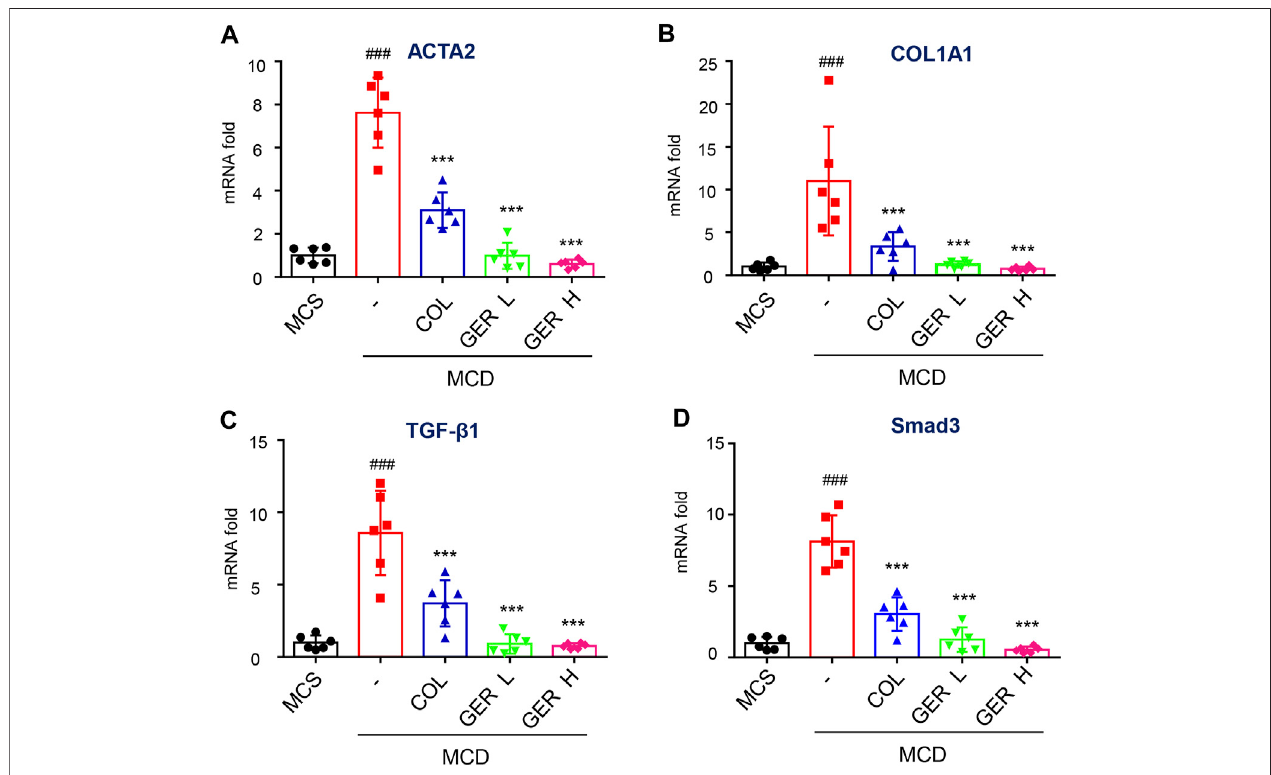
FIGURE 7 | GER inhibits the activation of HSCs via TGF- β /Smad signaling pathway in MCD diet-induced liver fi brosis model. (A – D) Quantitative real-time PCR analysis of ACTA2, COL1A1, TGF- β , and Smad3 mRNA expression in liver tissue ( n (cid:2) 6). All data are presented as means ± SEM. ### p < 0.001 vs. the MCS group. *p < 0.05, *** p < 0.001 vs. the model